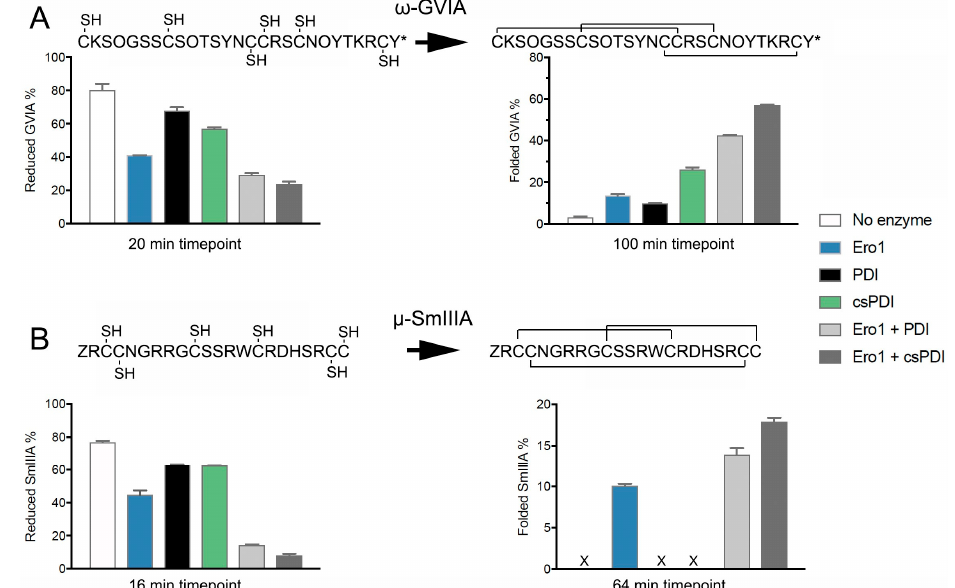
Figure 5. Oxidative folding assays of conotoxin ( A ) ω -GVIA and ( B ) µ -SmIIIA in the absence and presence of Ero1 and PDI or csPDI. The disappearance of the reduced form (oxidation reaction) and the appearance of the fully folded form (oxidation and isomerization reaction) are shown on the left and right, respectively. Folding assays were carried out in the absence or presence of 2 µ M PDI or 2 µ M csPDI and 4 µ M Ero1 in 100 mM Tris-HCl, 1 mM ethylenediaminetetraacetic acid EDTA, 0.2 mM FAD, pH 7.5. Folding was initiated by adding 20 µ M reduced toxin, which was quenched at different time points with formic acid and analyzed by reversed-phase chromatography. The area under the curve was measured for the reduced and fully folded forms. All reactions were carried out in duplicate. Plotted values represent mean ± SD. Toxin sequences with their native disulfide connectivity are shown above the graphs. Amino acid code: Z = pyroglutamate, O = hydroxyproline, * = C-terminal amidation. Values for statistical analyses are provided in Table S2.